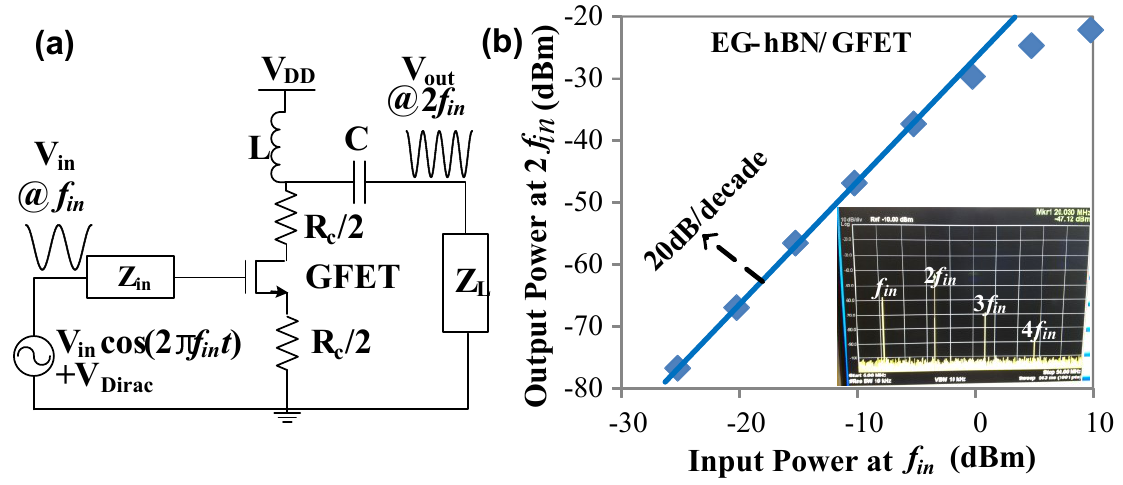
Figure 9. ( a ) GFET Doubler; and ( b ) Power Spectrum (adapted from [16], Copyright 2013, permission granted by